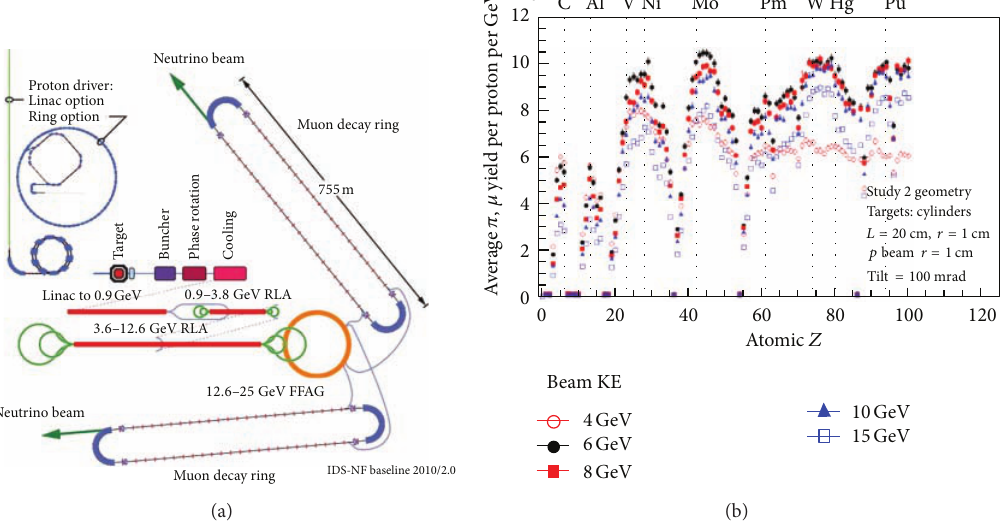
Figure 19: (a) Original baseline layout of the neutrino factory. (b) Pion production as a function of atomic number, assuming a cylindrical target 20cm long and 2cm in diameter.